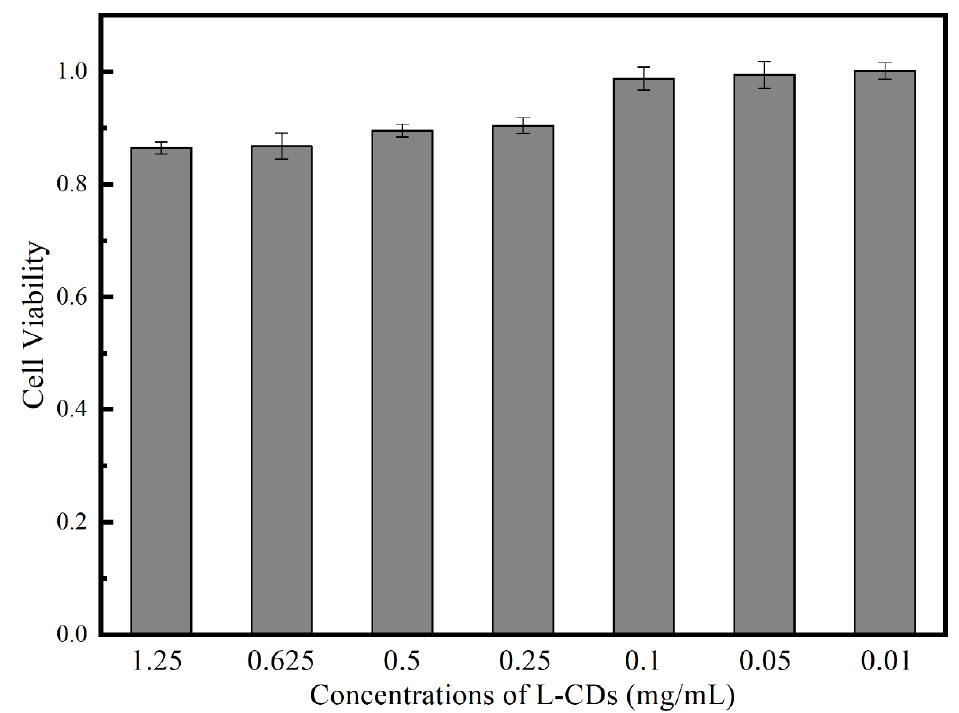
Figure 4. Cell viability values (%) estimated by WST-1 assay versus incubation concentrations of L-CDs (0, 0.05, 0.1, 0.25, 0.5, 0.625, and 1.25 mg/mL) at 37 °C for 24 h.